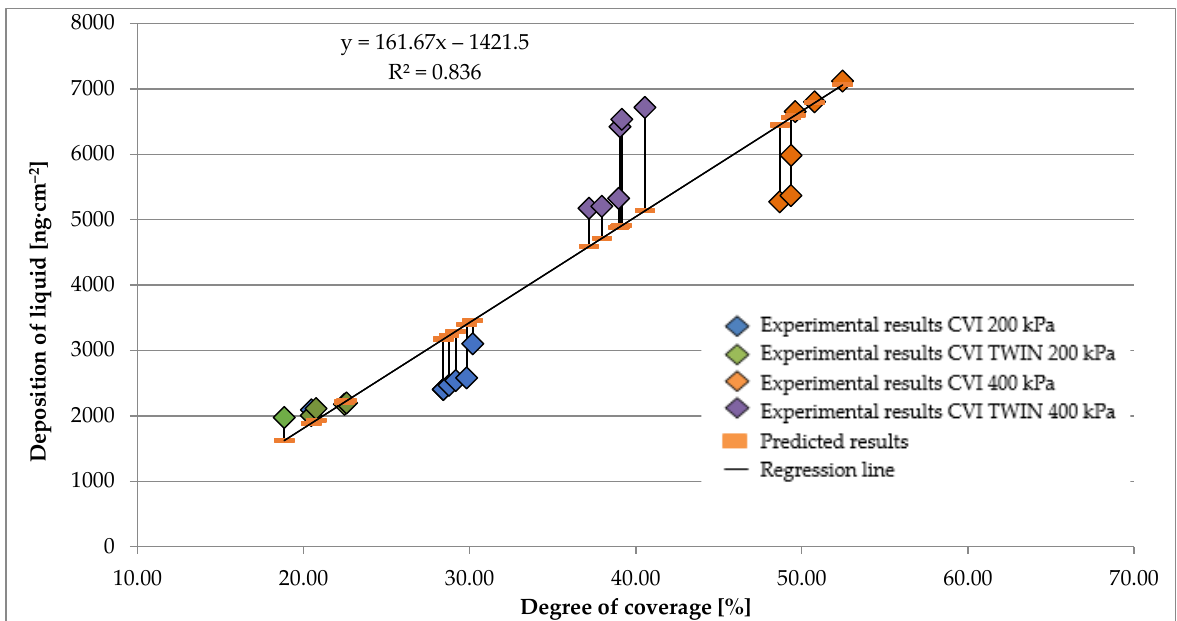
Figure 7. The scatter plot of the degree of coverage and deposition of spray liquid for selected air- induction nozzles for upper horizontal surface.